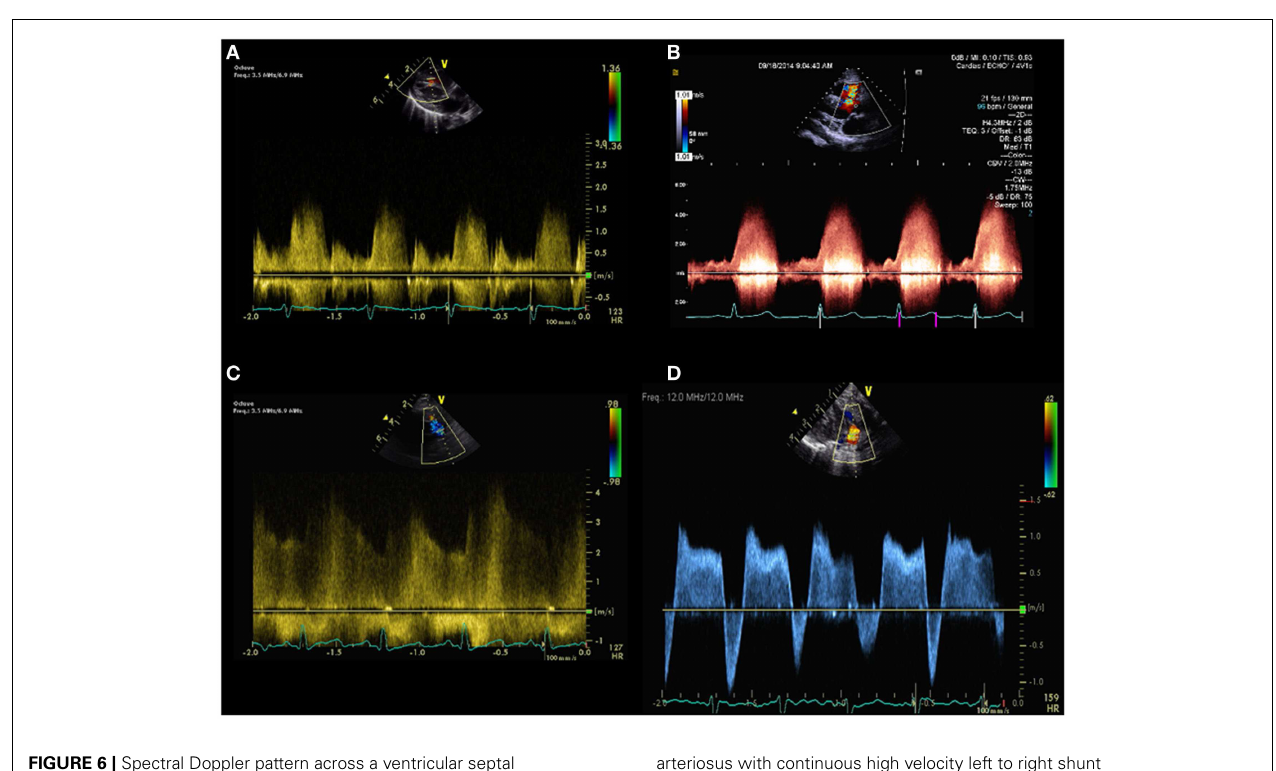
FIGURE 6 | Spectral Doppler pattern across a ventricular septal defect with low velocity left to right shunt (A) indicating pulmonary hypertension and high velocity left to right shunt (B) indicating low pulmonary pressure. Spectral Doppler pattern across patent ductus